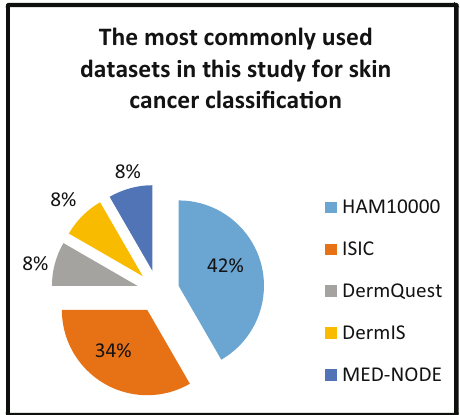
Figure 11: Most commonly used datasets in this study for skin cancer classi fi